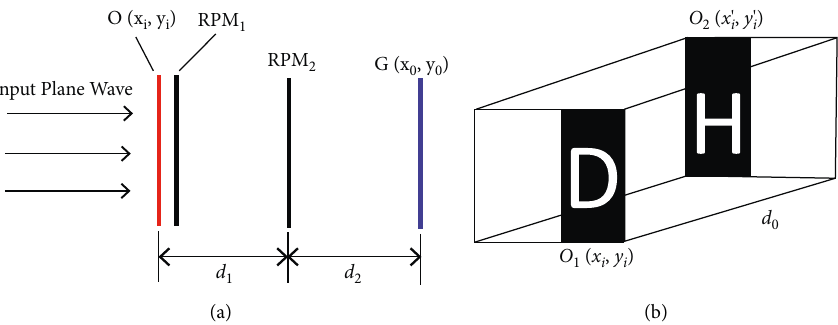
, y ) is a 2D complex i i 1 and d 2 are ( x ,y ) is an object at plane i ′ i ′ 2